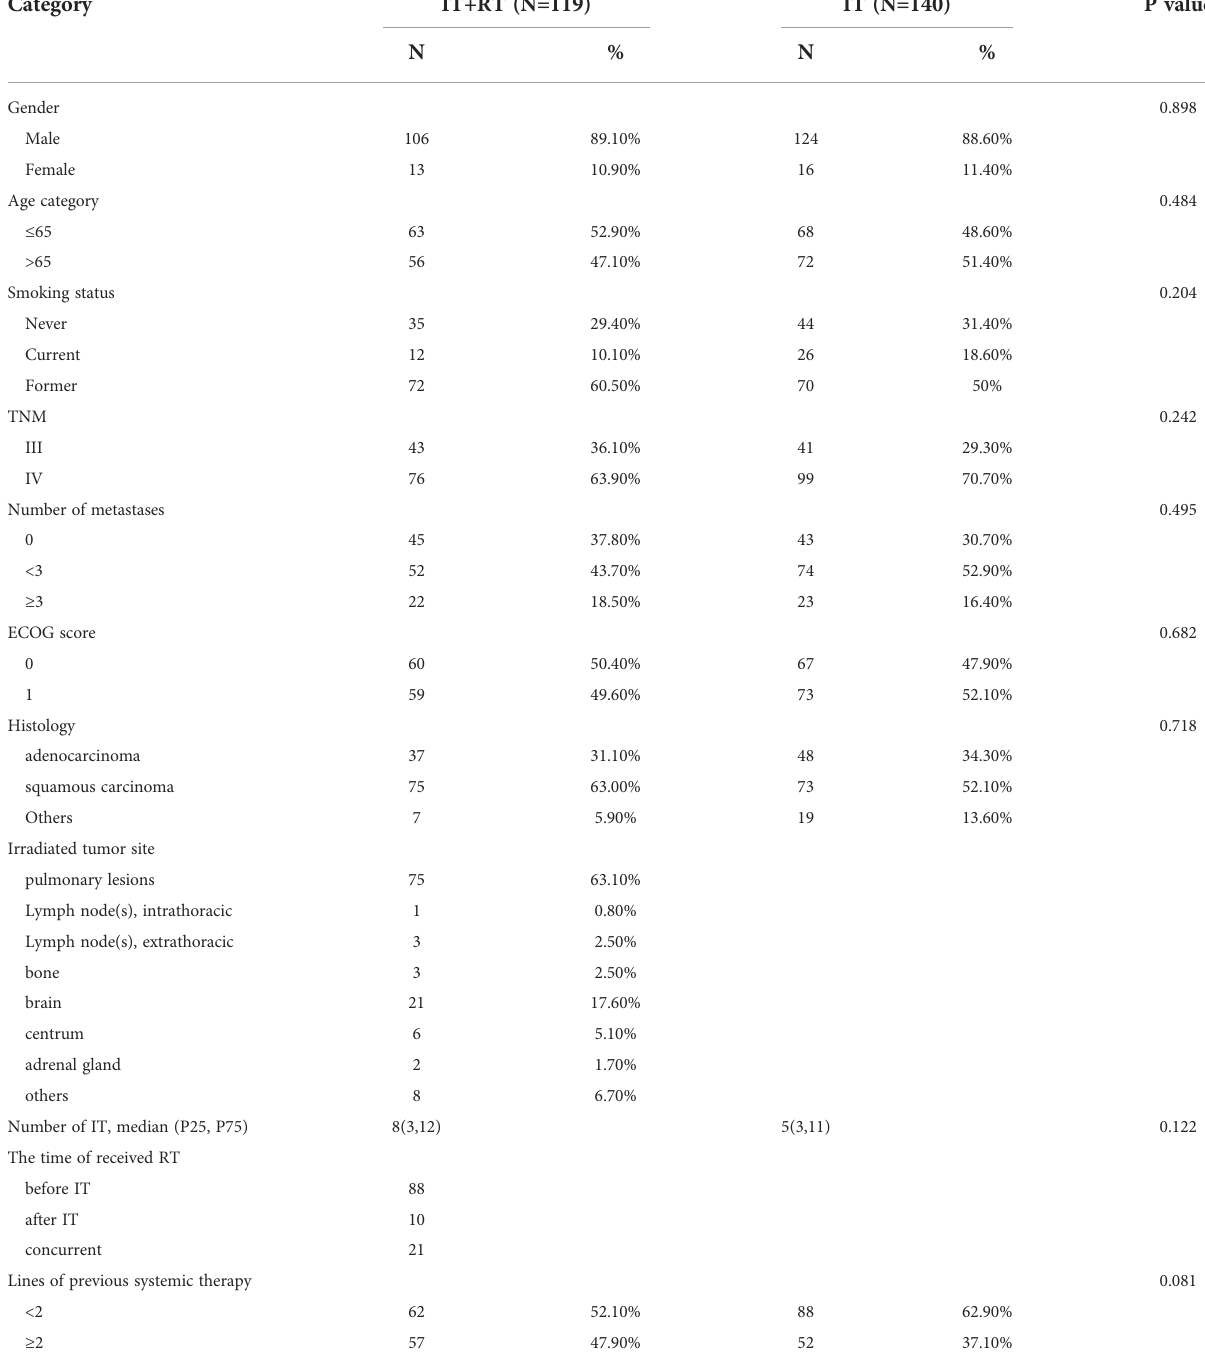
TABLE 1 Patient Clinical